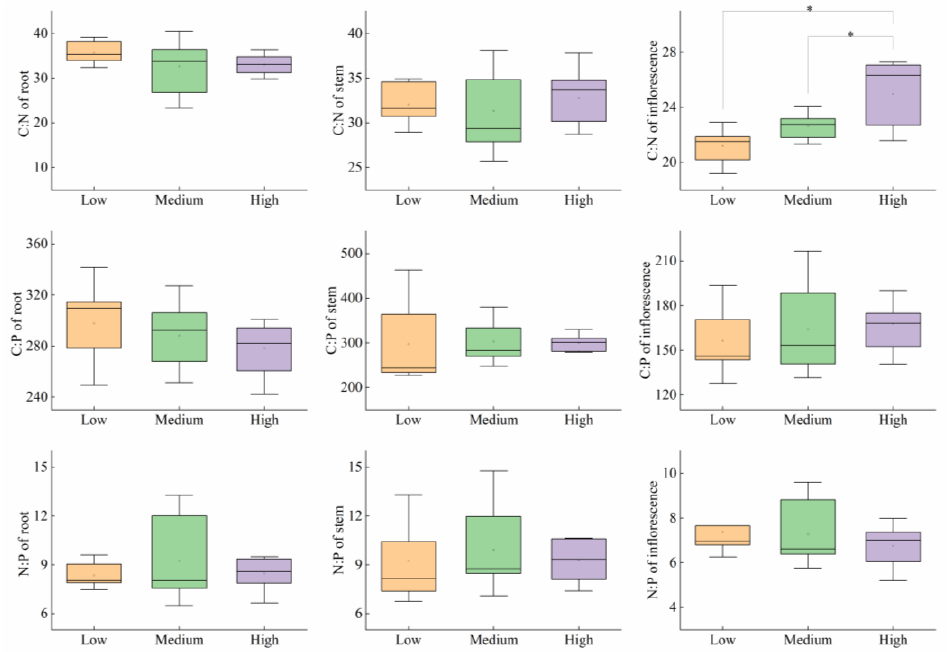
Figure 4. Differences of C:N, C:P, and N:P in structures of Pedicularis kansuensis among the different invasion levels. * indicates a significant difference ( p < 0.05).